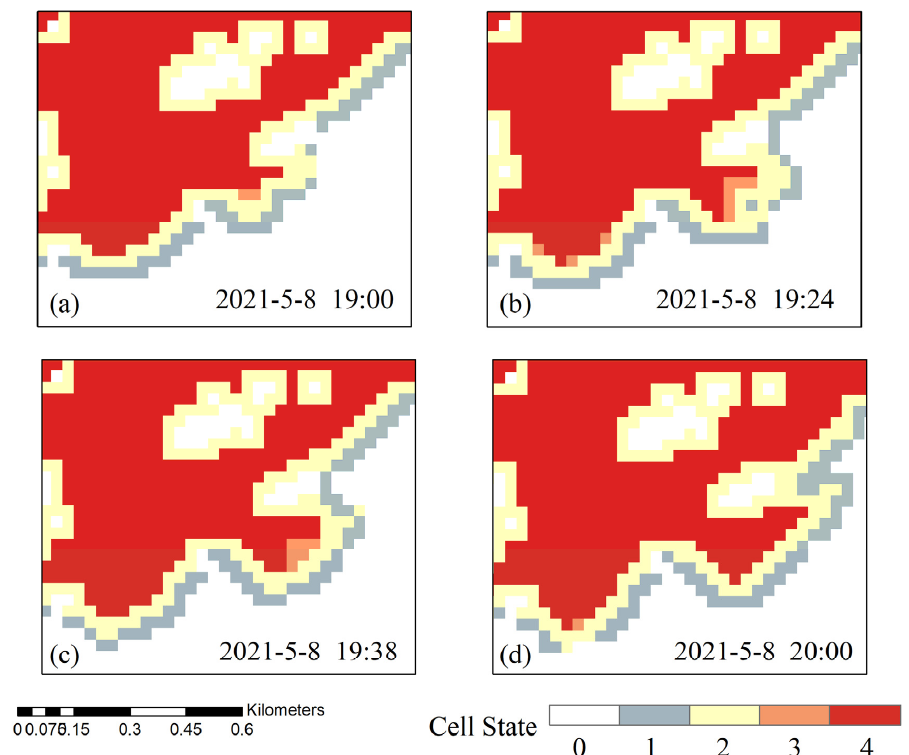
Figure 8. Predicted forest fire spread simulation map for 8 May 2021 19:00–20:00: ( a ) traditional CA model simulation graph for 8 May 2021, at 19:00; ( b ) adaptive CA model simulation graph for 8 May 2021, at 19:24; ( c ) adaptive CA model simulation graph for 8 May 2021, at 19:38; ( d ) traditional CA model simulation graph for 8 May 2021, at 20:00.